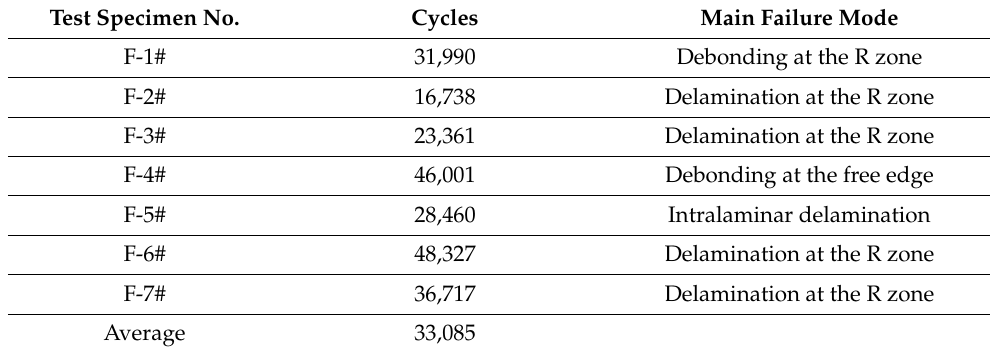
Table 5. Fatigue failure life and main failure mode of the test specimens.